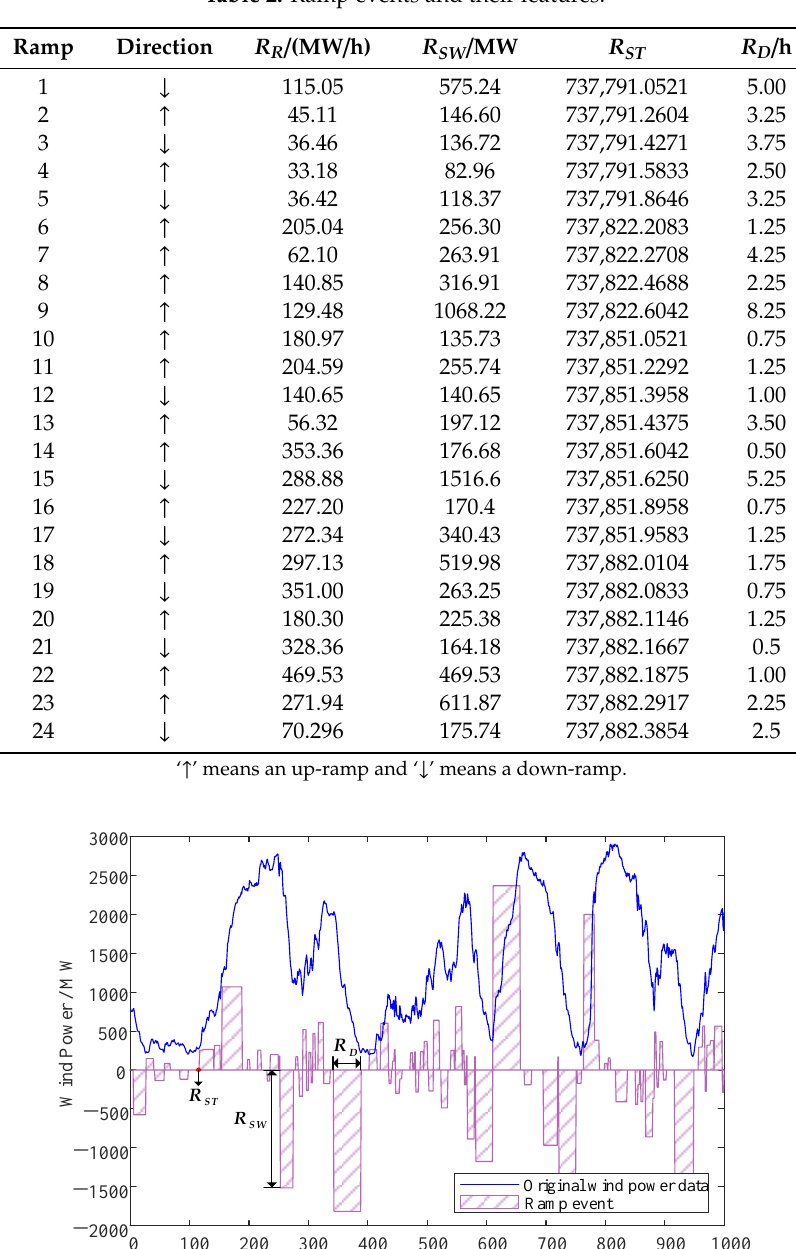
Table 2. Ramp events and their features.